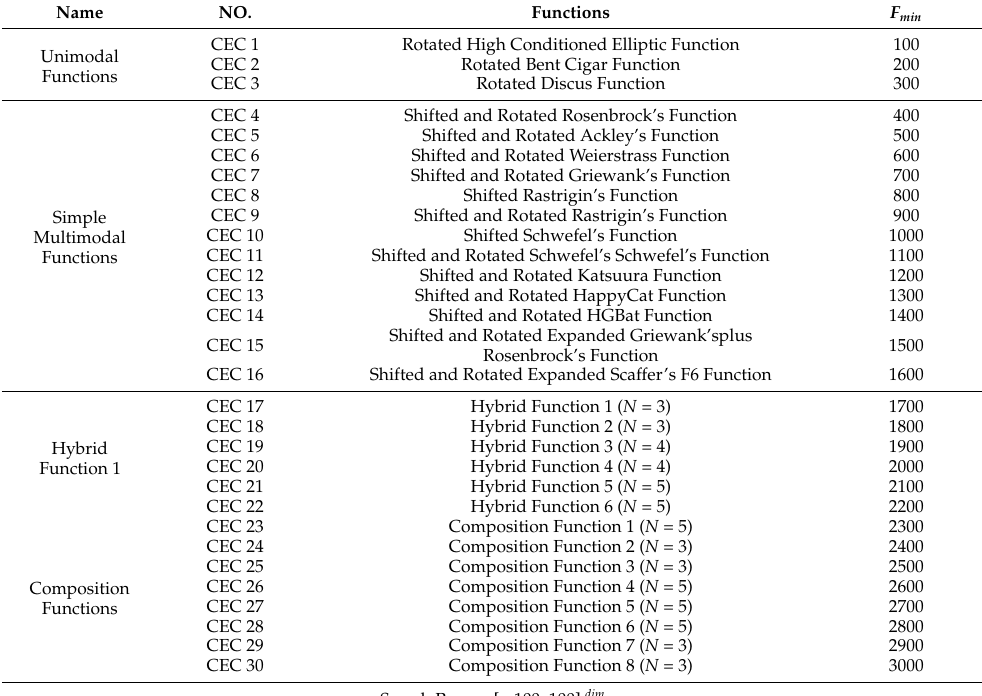
Table 7. Details of 30 CEC2014 benchmark